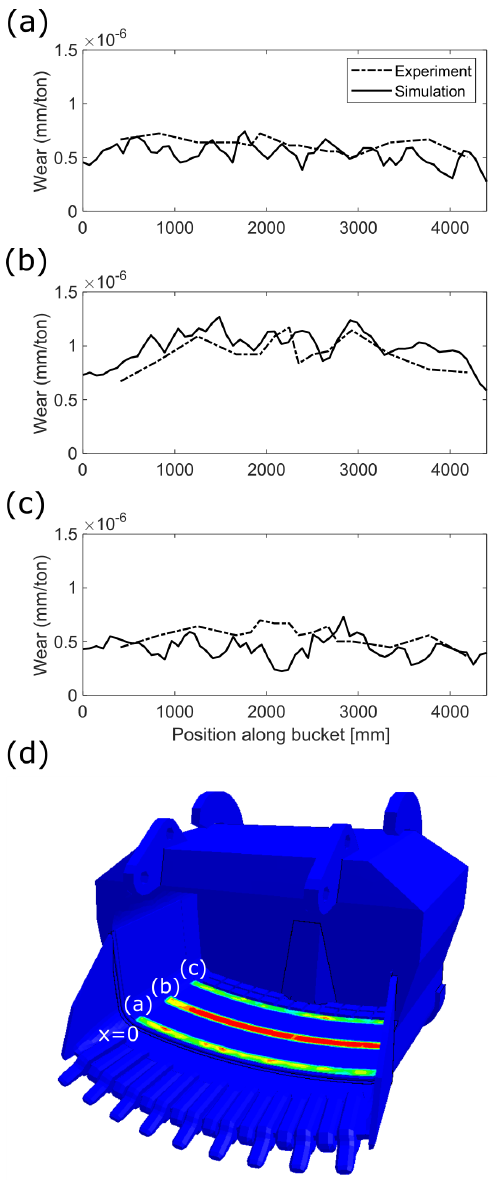
Figure 19. Wear rate is plotted as sections from the width direction of the bucket and plotted for both experimentally measured and simulated wear, in the front ( a ), middle ( b ), and in the rear of the bucket ( c ). The locations ( d ) of the sections in the bucket are illustrated. Experimental data are from the points in Figure 18, corresponding to approximately the same positions. The dashed line corresponds to experimental wear rate and the full drawn line corresponds to simulated wear rate. The x-axes are the same for all plots ( a – c